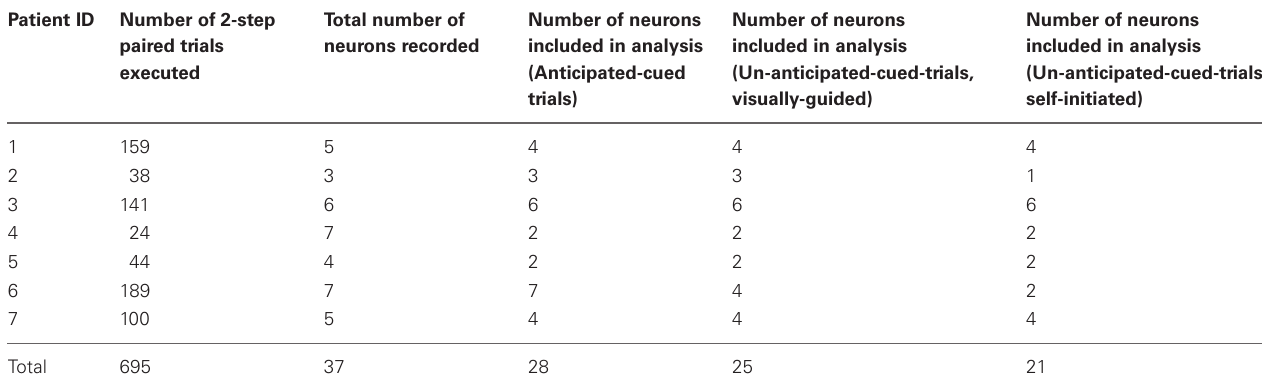
Table 1 | Distribution of trials and recorded neurons per patient. Patient ID Number of